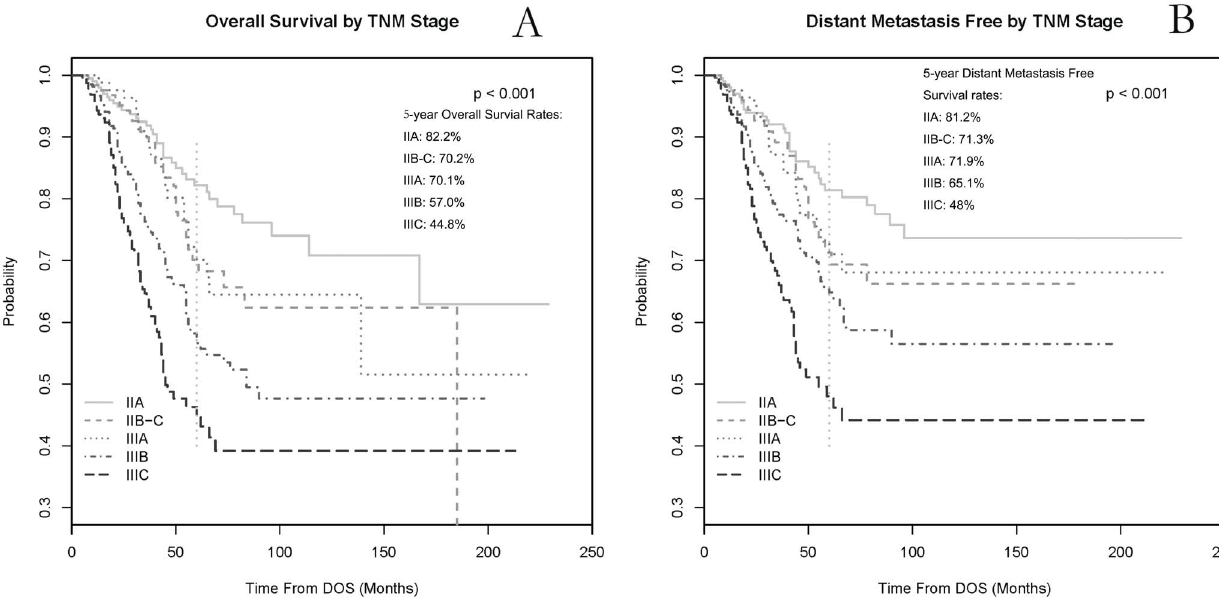
Figure 2. The overall survival (A) and distant metastases free (B) Kaplan-Meier probability curves within each stage (AJCC 7 th Edition) classification in locally advanced rectal cancer. doi:10.1371/journal.pone.0106344.g002 PLOS ONE |